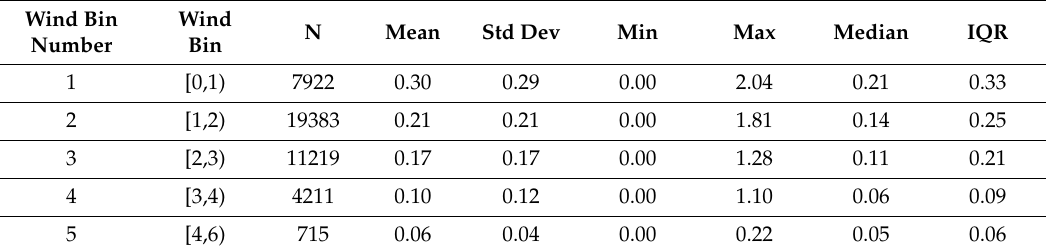
Table A1. Statistics of the Absolute Temperature Di ff erences ( ◦ C) in five wind speed bins used to assess the precision of the iMET-XQ sensors as a function of wind speed. IQR stands for Inter-Quartile Range. Wind Bin